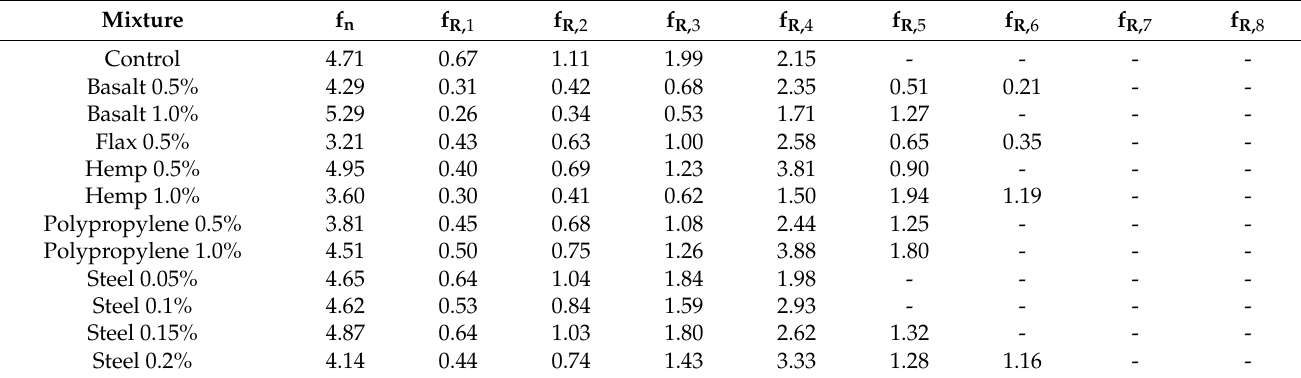
Table 9. Flexural tensile strength (f n ) and (f R,j ) [MPa], j values from Table